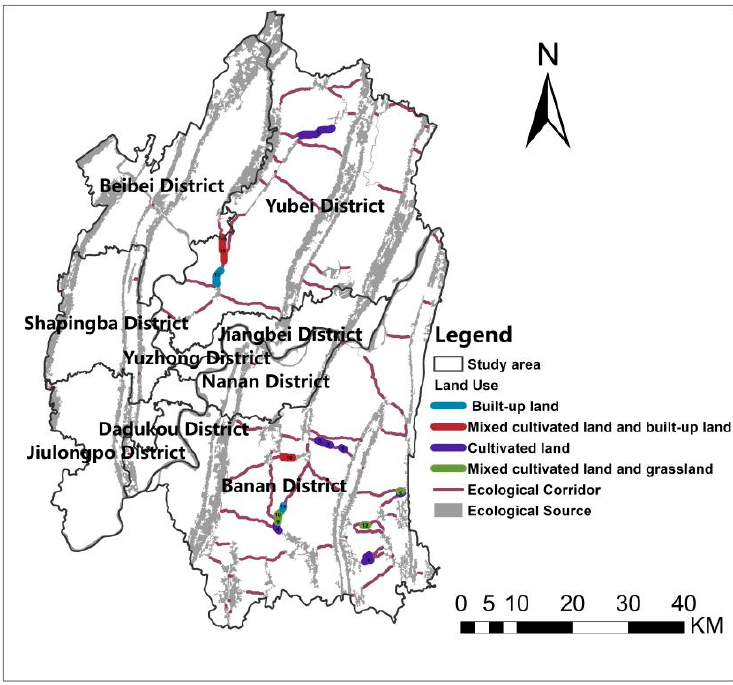
Figure 12. Types of land use at ecological barrier points.